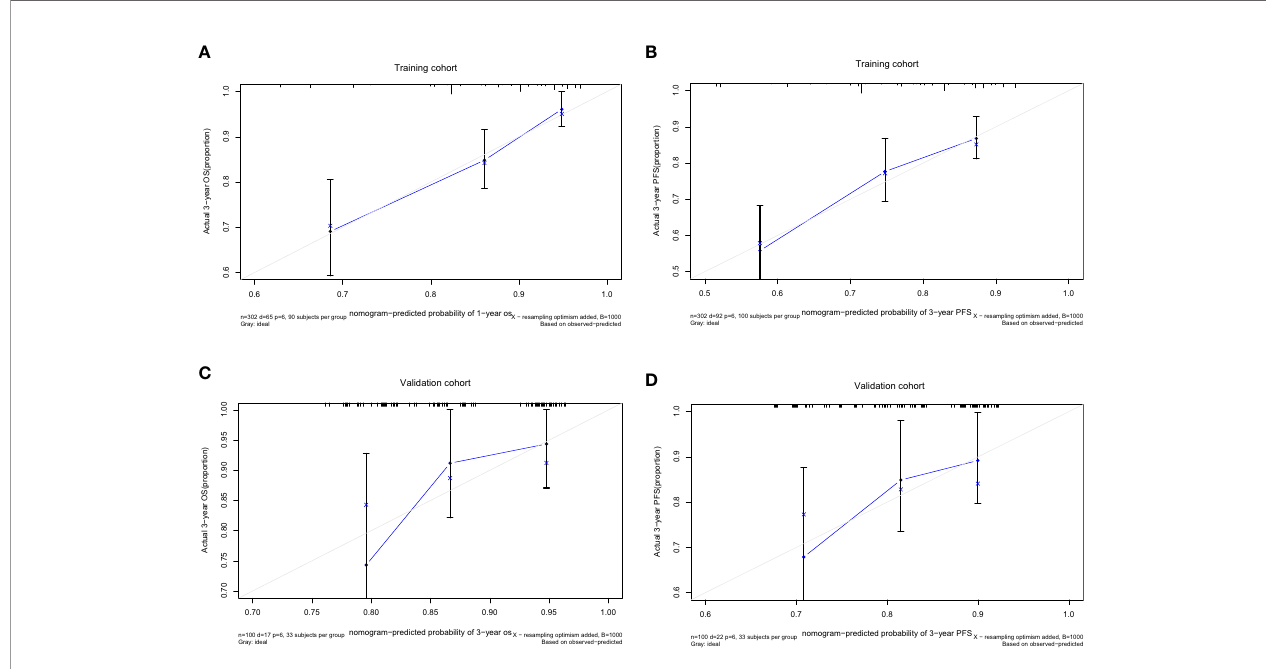
FIGURE 2 | The Calibration plots of the nomogram in predicting OS and PFS at 3 year in the training (A, B) and validation cohorts (C, D) .